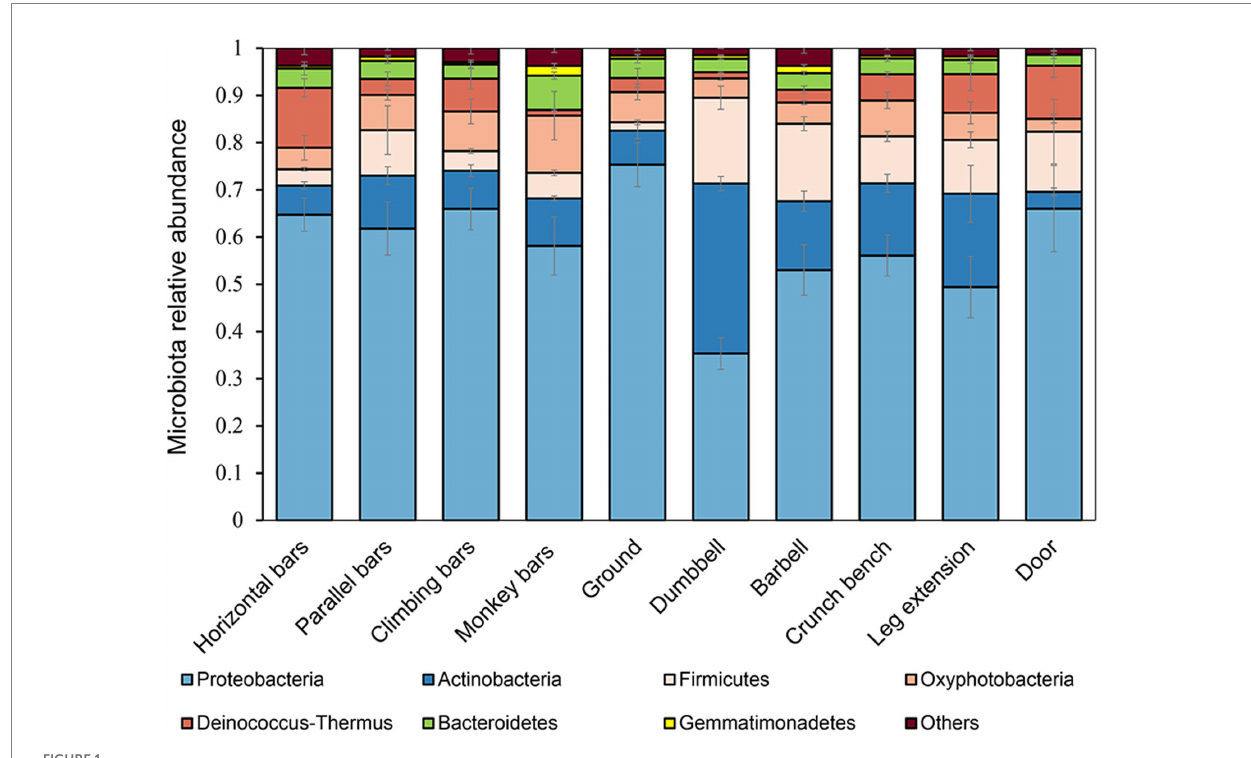
FIGURE 1 Microbial community structures on the surfaces of gymnastic